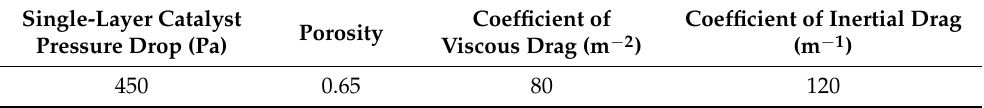
Table 5. Parameters of catalyst